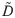
Dynamics of Brazilian states in the Fitness-Income plane.a) The figure shows the evolution (from 2000 to 2015) of the Brazilian states in the Fitness-Income plane in logarithmic scale. The dotted black line in the figure shows the expected level of GDPp given the level of Fitness and it is the result of the minimization of the Euclidean distance of the states from the line, weighted by the states GDP. b) The figure shows the coefficient D˜ calculated considering a time window from 2003 to 2013. The color varies from green (where the versors of evolution tend to be parallel), to red (where the versors tend to be unevenly directed). c) The figure shows a grid where for each cell we calculate the versor of the sum vector. From the figure two regions appear: the first one where the versors tend to be parallel in the direction of a high GDPp (shown in green); and the second one where the versors tend to be unevenly directed (shown in red). Fig 8b and c together show that there is a region (green) of high predictability of motion in direction of a high GDPp; and a region (red) of low predictability of motion. d) The figure shows the dynamics (from 2000 to 2015) of the Brazilian states in the Fitness-Income plane highlighting in green the states in the high predictability region and in red the states in the low predictability one.